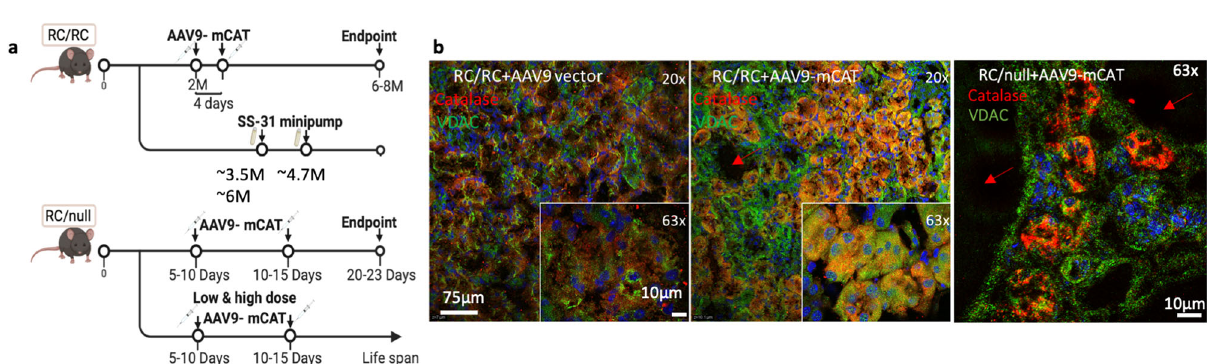
Fig. 2 Strategies to protect mitochondria. a Experimental design of the in vivo study (created by biorender). b Immuno fl uorescence of catalase (red) and the mitochondrial marker VDAC (green) in kidney tubular epithelial cells from RC/RC mice injected with AAV9 alone (RC/RC + AAV9 vector) or RC/RC and RC/null mice injected with AAV9 overexpressing catalase targeted to mitochondria (RC/RC + AAV9-mCAT) at low (20×) and high objective (63×) magni fi cation (inset); n = 3 per group. Red arrows indicate